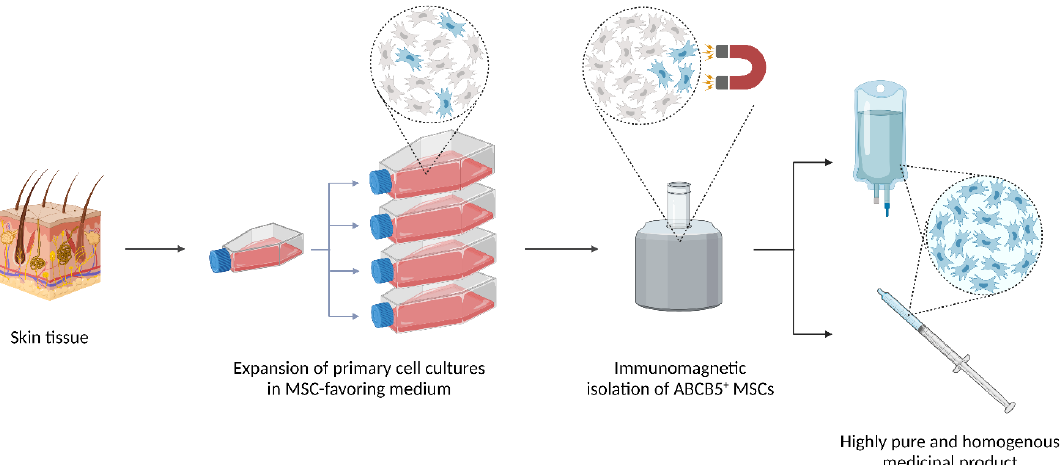
Figure 1. Schematic representation of the good practice-compliant manufacturing process of ABCB5 + mesenchymal stem cells (MSCs). Human skin tissue is enzymatically digested, and cells are expanded as unsegregated culture upon adherence selection in an in-house MSC-favoring medium. After serial passaging for up to 16 passages, ABCB5 + cells are isolated by immunomagnetic bead cell sorting using an antibody directed against an extracellular sequence of the ABCB5 molecule. The final medicinal product is formulated by thawing and reconstituting isolated, cryopreserved ABCB5 + MSCs in Ringer’s lactated solution supplemented with human serum albumin and glucose in infusion bags or syringes as needed. While initially all cells were supplied as reconstituted ready-to-use products, they can now also be delivered as frozen vials on dry ice to be thawed and reconstituted at the clinical site, which provides for prolonged transport stability required for worldwide shipping. Created with